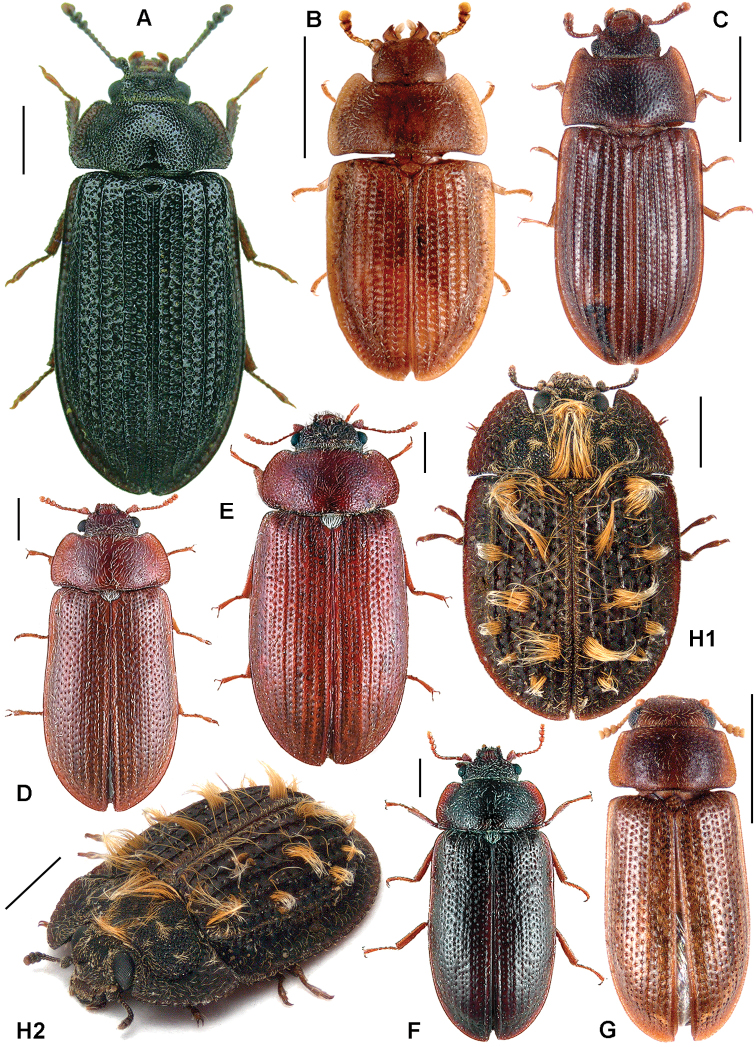
A
Grynocharis oblonga
B
Grynocharina peltiformis
C
Lophocateres pusillus
D
Promanus auripilis
E
Promanus subcostatus
F
Promanus depressus
G
Peltonyxa sp., Australia, NSW H
Trichocateres fasciculifer.